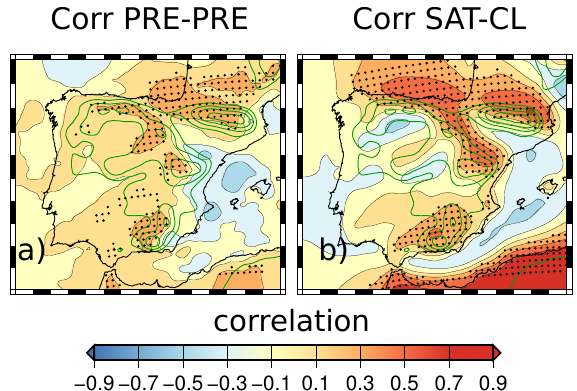
Fig. 8. Physical response of winter precipitation over the IP. (a) shows the correlation between precipitation series in the MM5- ERIK1 and MM5-ERIK2 experiments, and it is the analog to Fig. 3 but using a low-pass filter instead of running means. (b) depicts the correlation between the temperature and height of the condensation level in the MM5-ERIK2 experiment. All calculations were per- formed using the low-frequency series. Green contours indicate the terrain height above 500m spaced by 300m. Black circles denote grid points where the correlation is significant at the 95% confi- dence level according to a bootstrap method (Ebisuzaki,